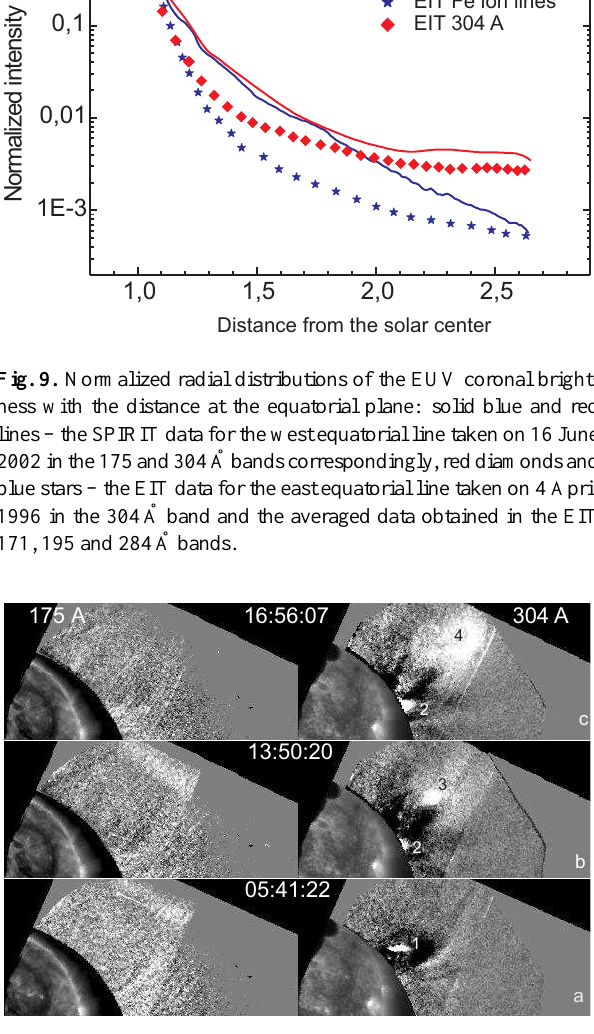
Fig. 10. Selected SPIRIT images of the failed prominence eruption and CME observed on 2 February 2003 at 05:41:22, 13:50:20 and 16:56:07UT in the 175 ˚A (left) and 304 ˚A (right) bands: 1 – the prominence before eruption; 2 – a brightening after the failed erup- tion; 3, 4 – different stages of the CME development. The coronal parts are shown as the base difference images with the reference image taken at